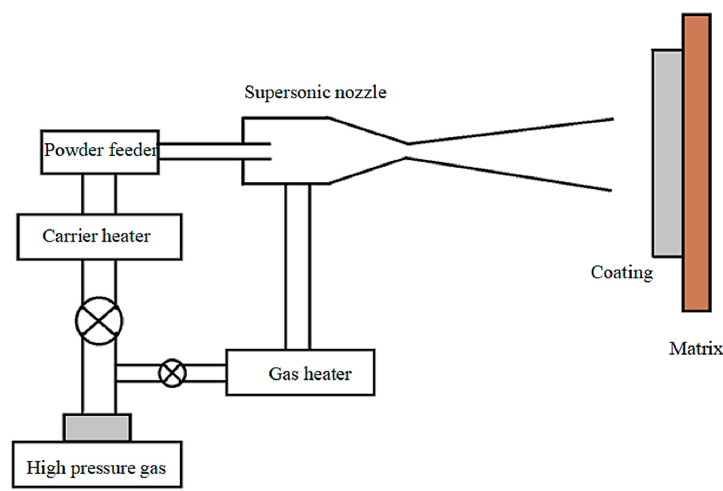
Figure 1. The schematic diagram of the working principle of the cold spray coating preparation.